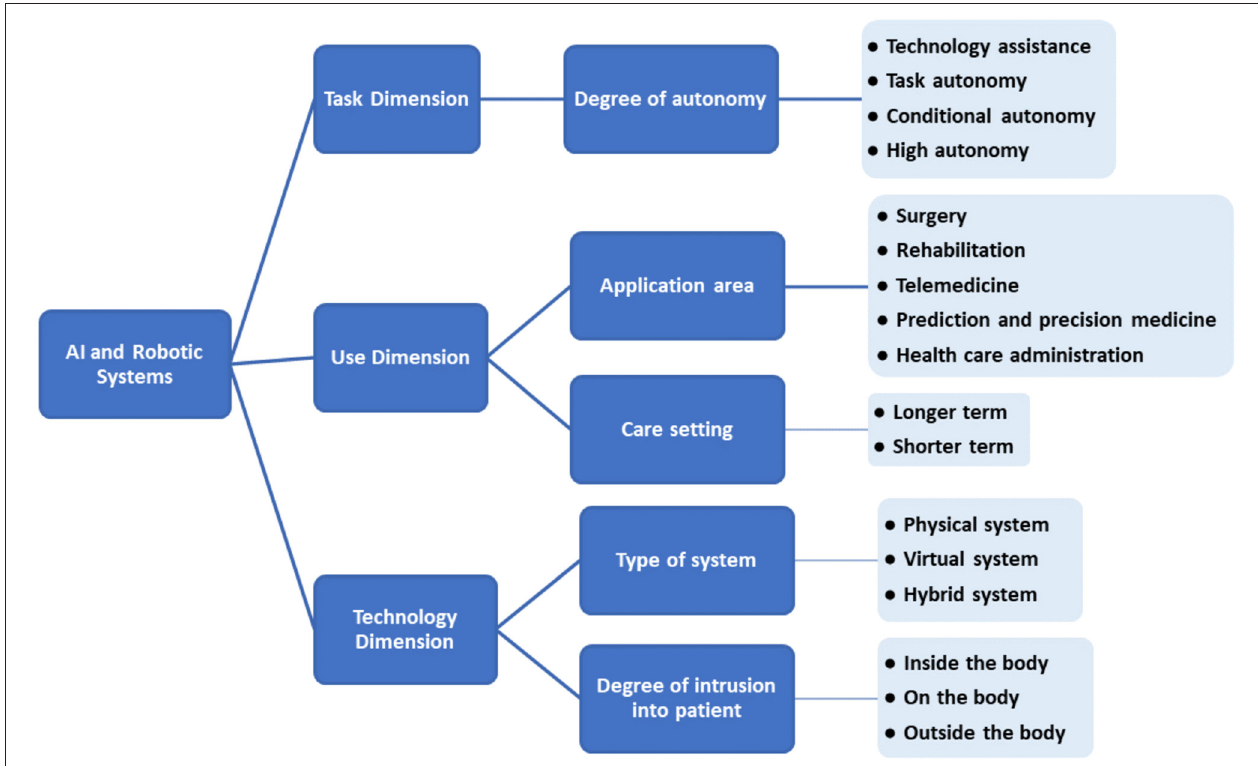
FIGURE 1 | Categorization of systems based on AI and robotics in health